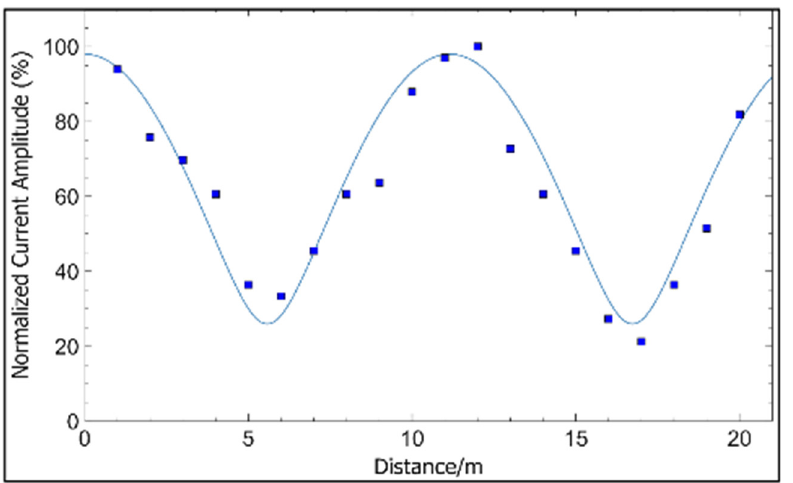
Figure 2. Current amplitude distribution along the loop (normalised (%); measurement points and fitting to a stationary wave envelope function).